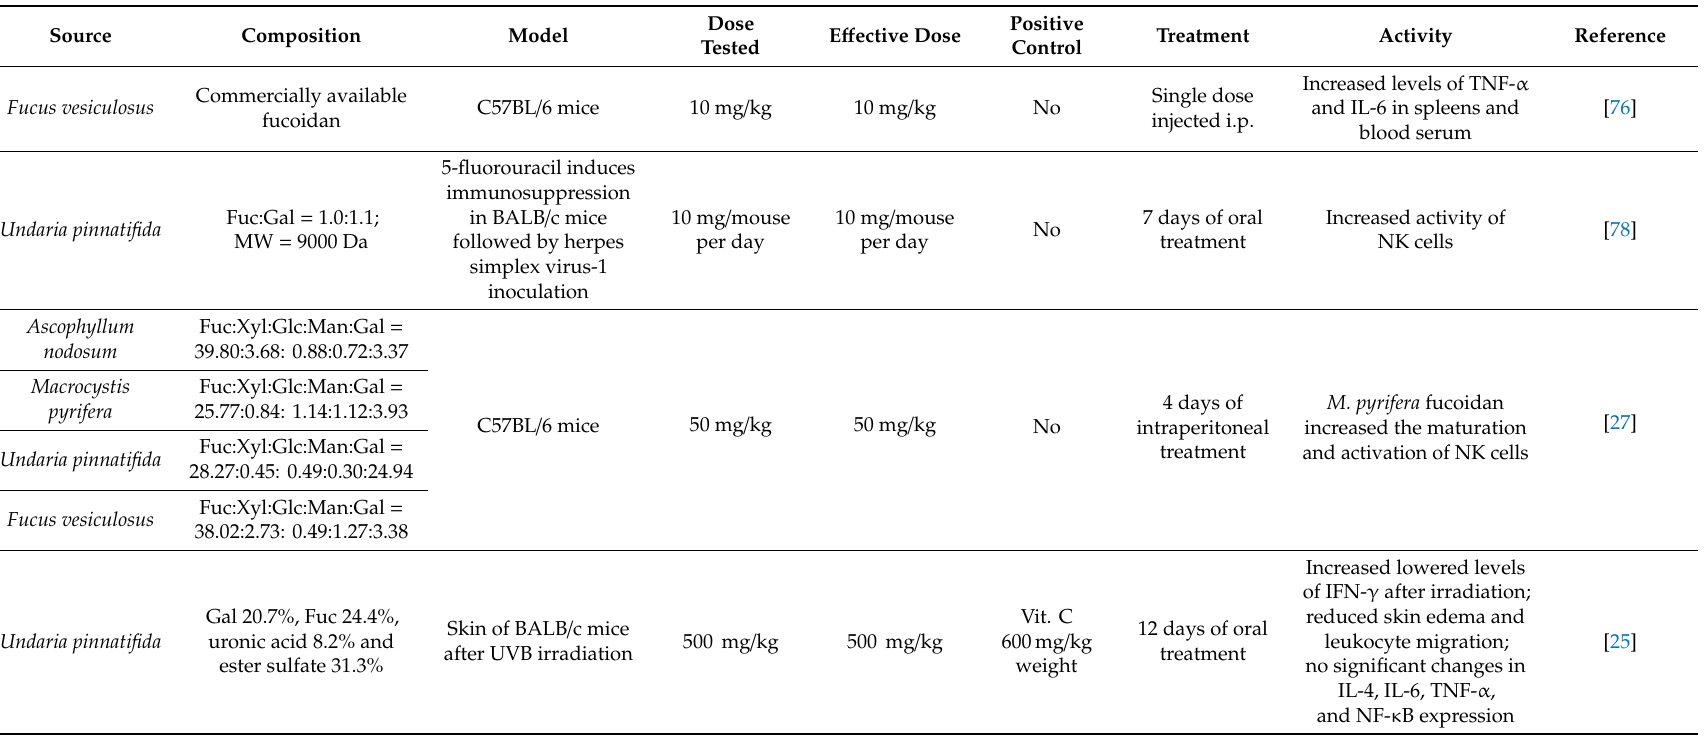
Table 4. In vivo immunomodulatory activity of